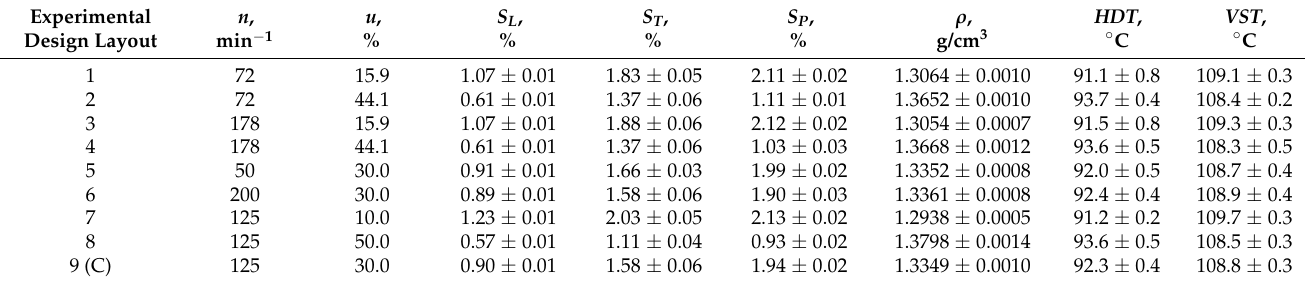
Table 1. Experimental design and experimental test results—mean values and standard deviation—part I. Experimental Design Layout